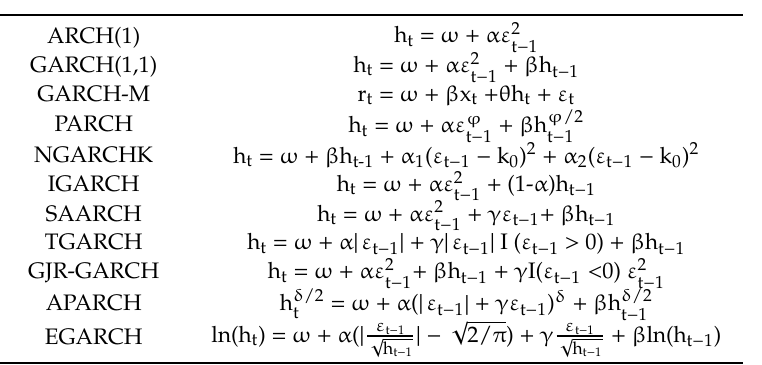
Table 1. Autoregressive Conditional Heteroskedastic (ARCH)-type models [30] (h t denotes conditional variance, ω the constant, α the ARCH e ff ect, and β the GARCH e ff